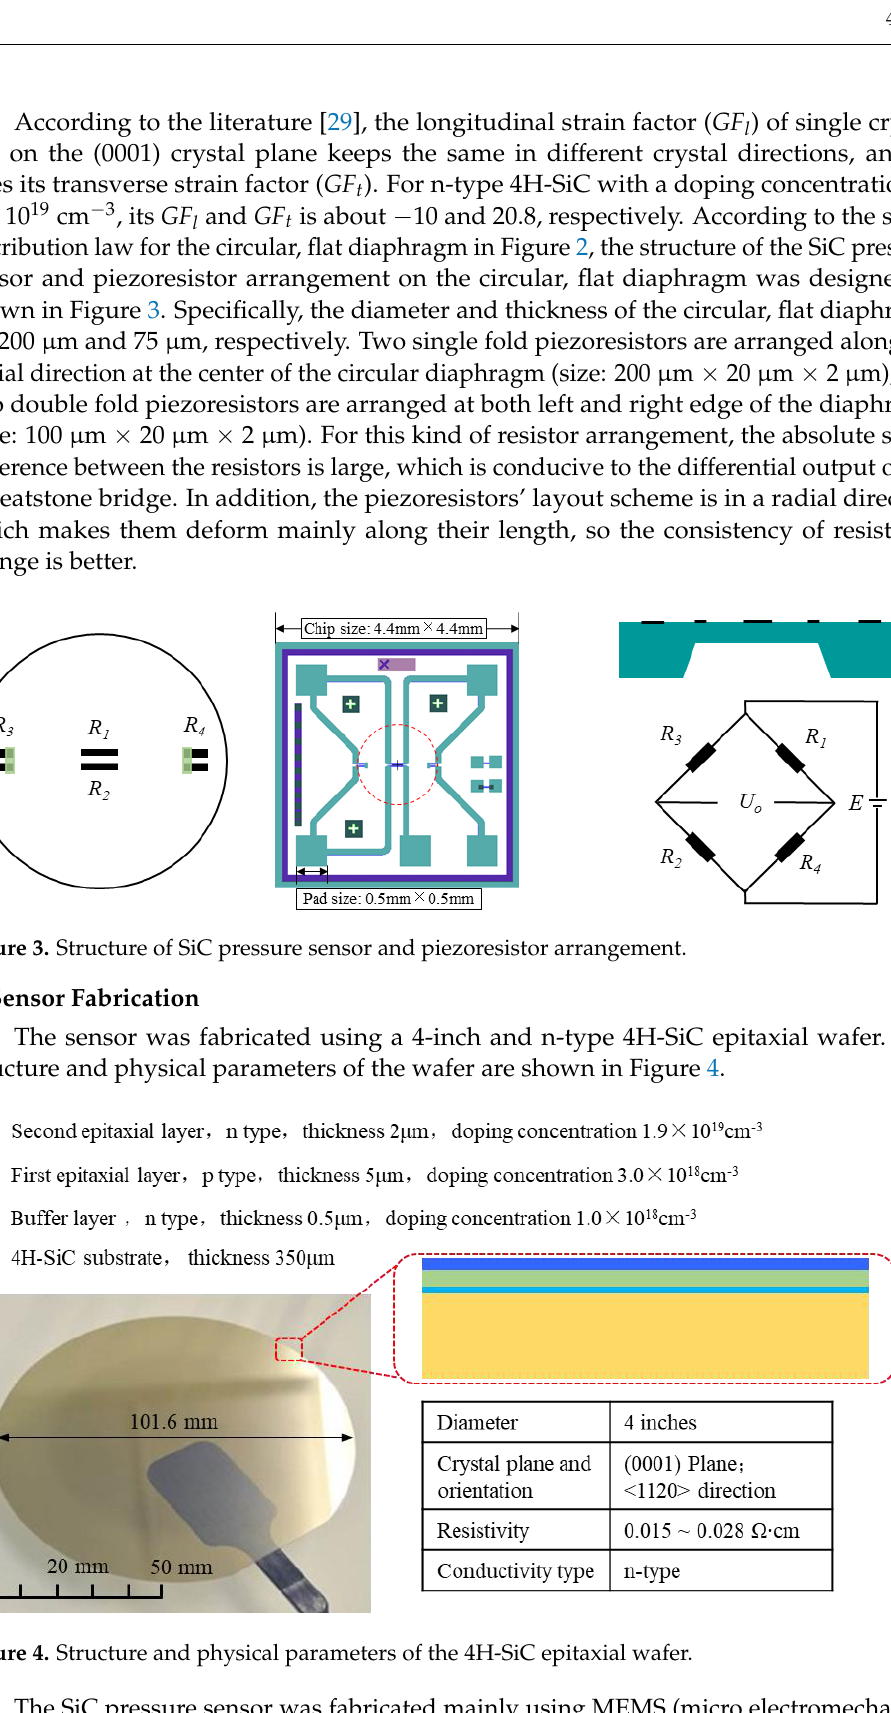
Figure 2. Stress variation curve and equivalent stress distribution on the circular, flat diaphragm.